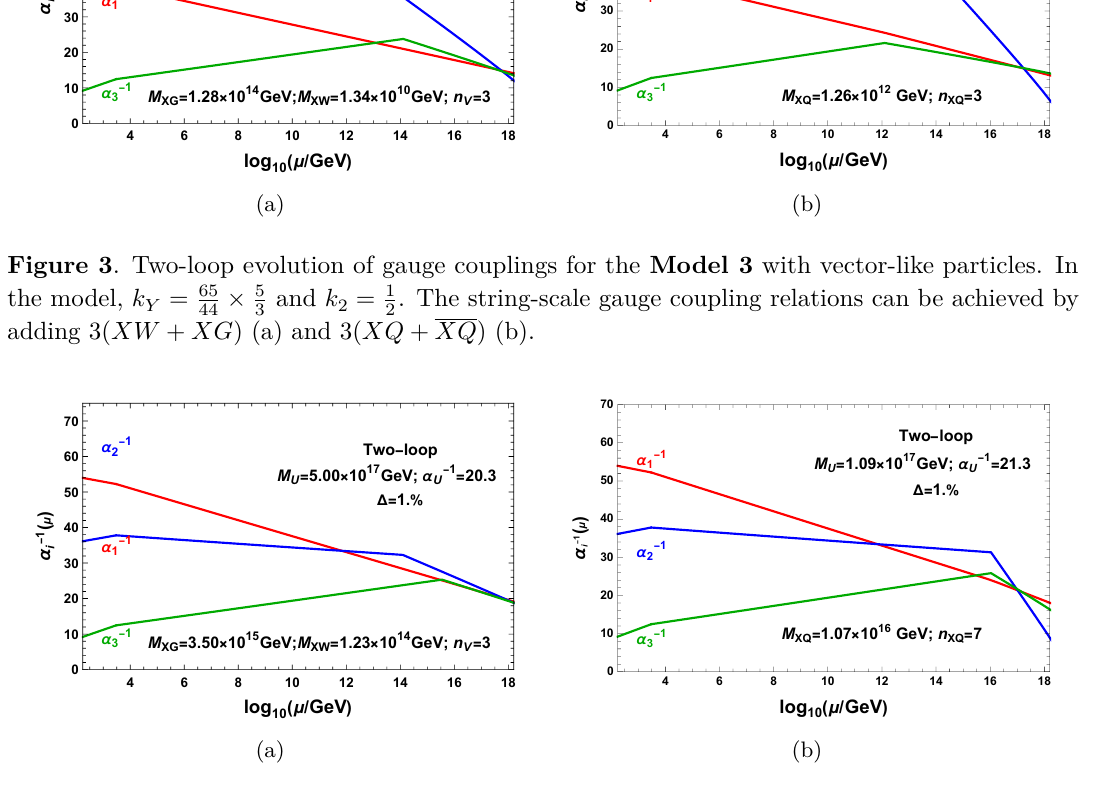
Figure 4 . Two-loop evolution of gauge couplings for the Model 4 with vector-like particles. In the model, k = 35 × 5 and k = 5 . The string-scale gauge coupling relations can be achieved by Y 2 32 3 6 adding 3( XW + XG ) (a) and 7( XQ + XQ )